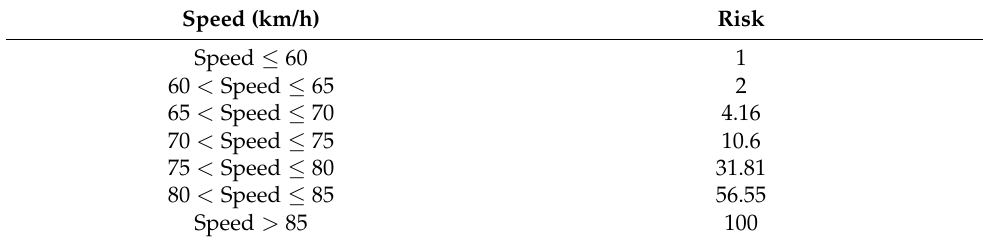
Table 2. Risk of speeding under 60 km/h speed limit condition.